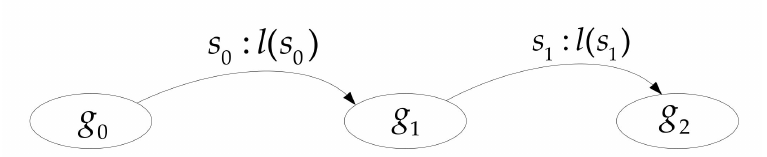
Figure 3. A finite automaton preventive control model of an